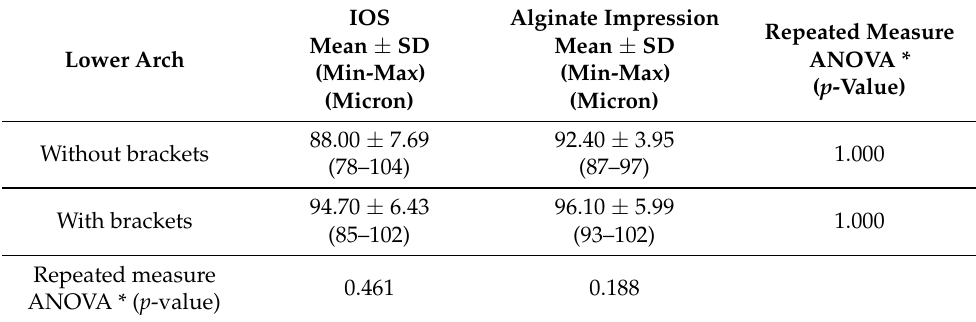
Table 2. Average surface deviation (mean difference and standard deviation) in measurements by IOS, alginate, and control in the lower arch.